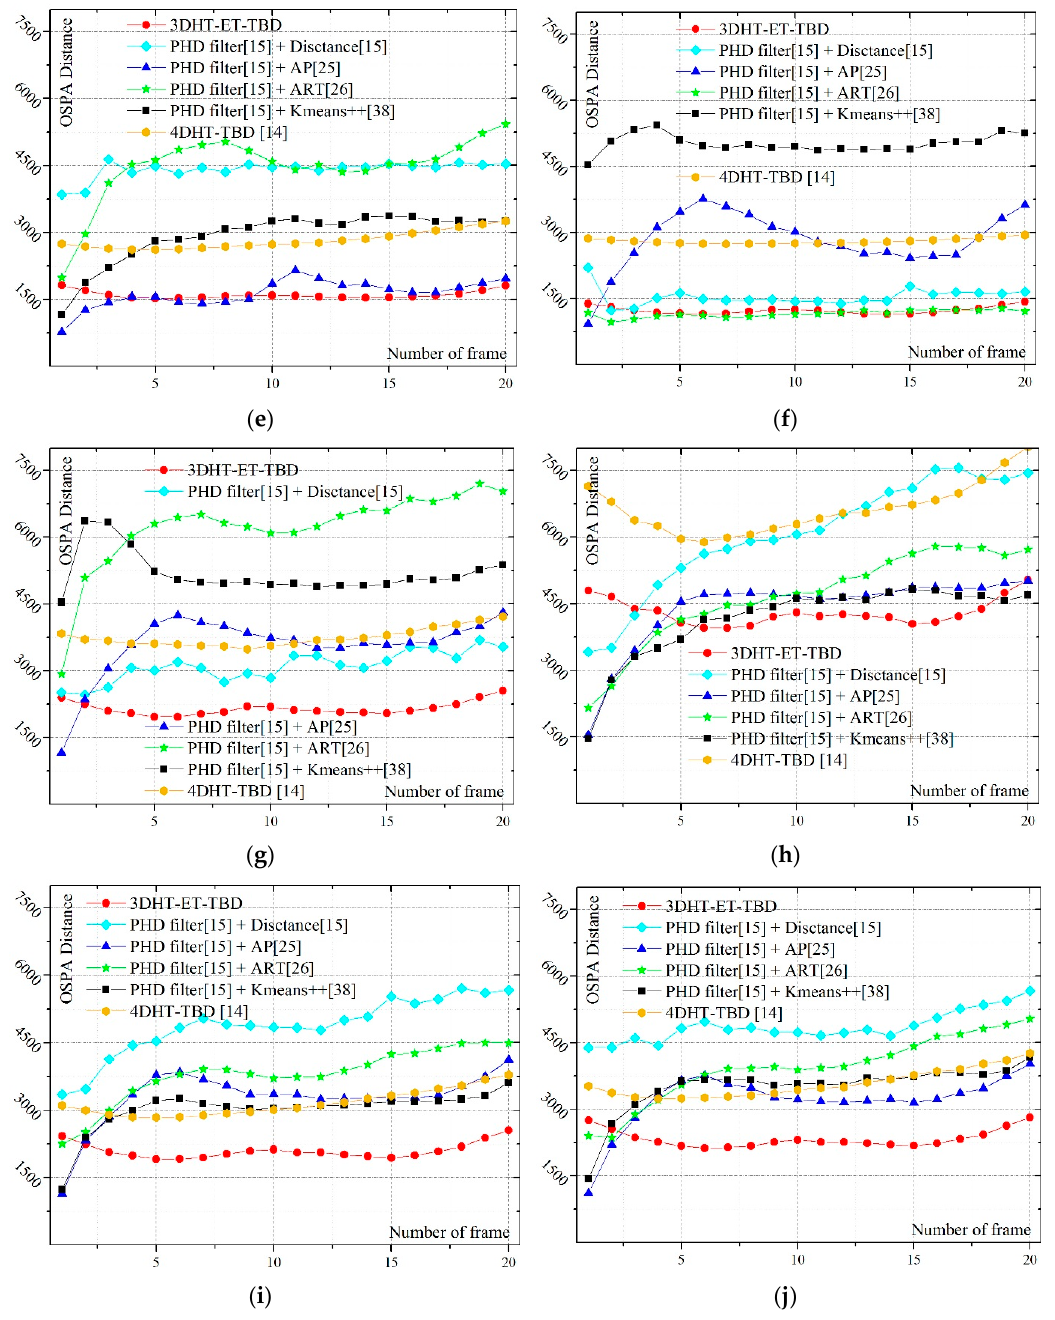
Figure 4. The OSPA distance of 10 scenarios at each scan. ( a – j ) corresponds to scenarios 1–10. The average OSPA distance in different scenarios is presented in Table 2. The lowest OSPA distance in each scenario is emphasized in boldface. It can be seen that 3DHT-ET-TBD is the best almost in all scenarios. The robustness and effectiveness of the 3DHT-ET-TBD under various circumstances have been proved again by Table